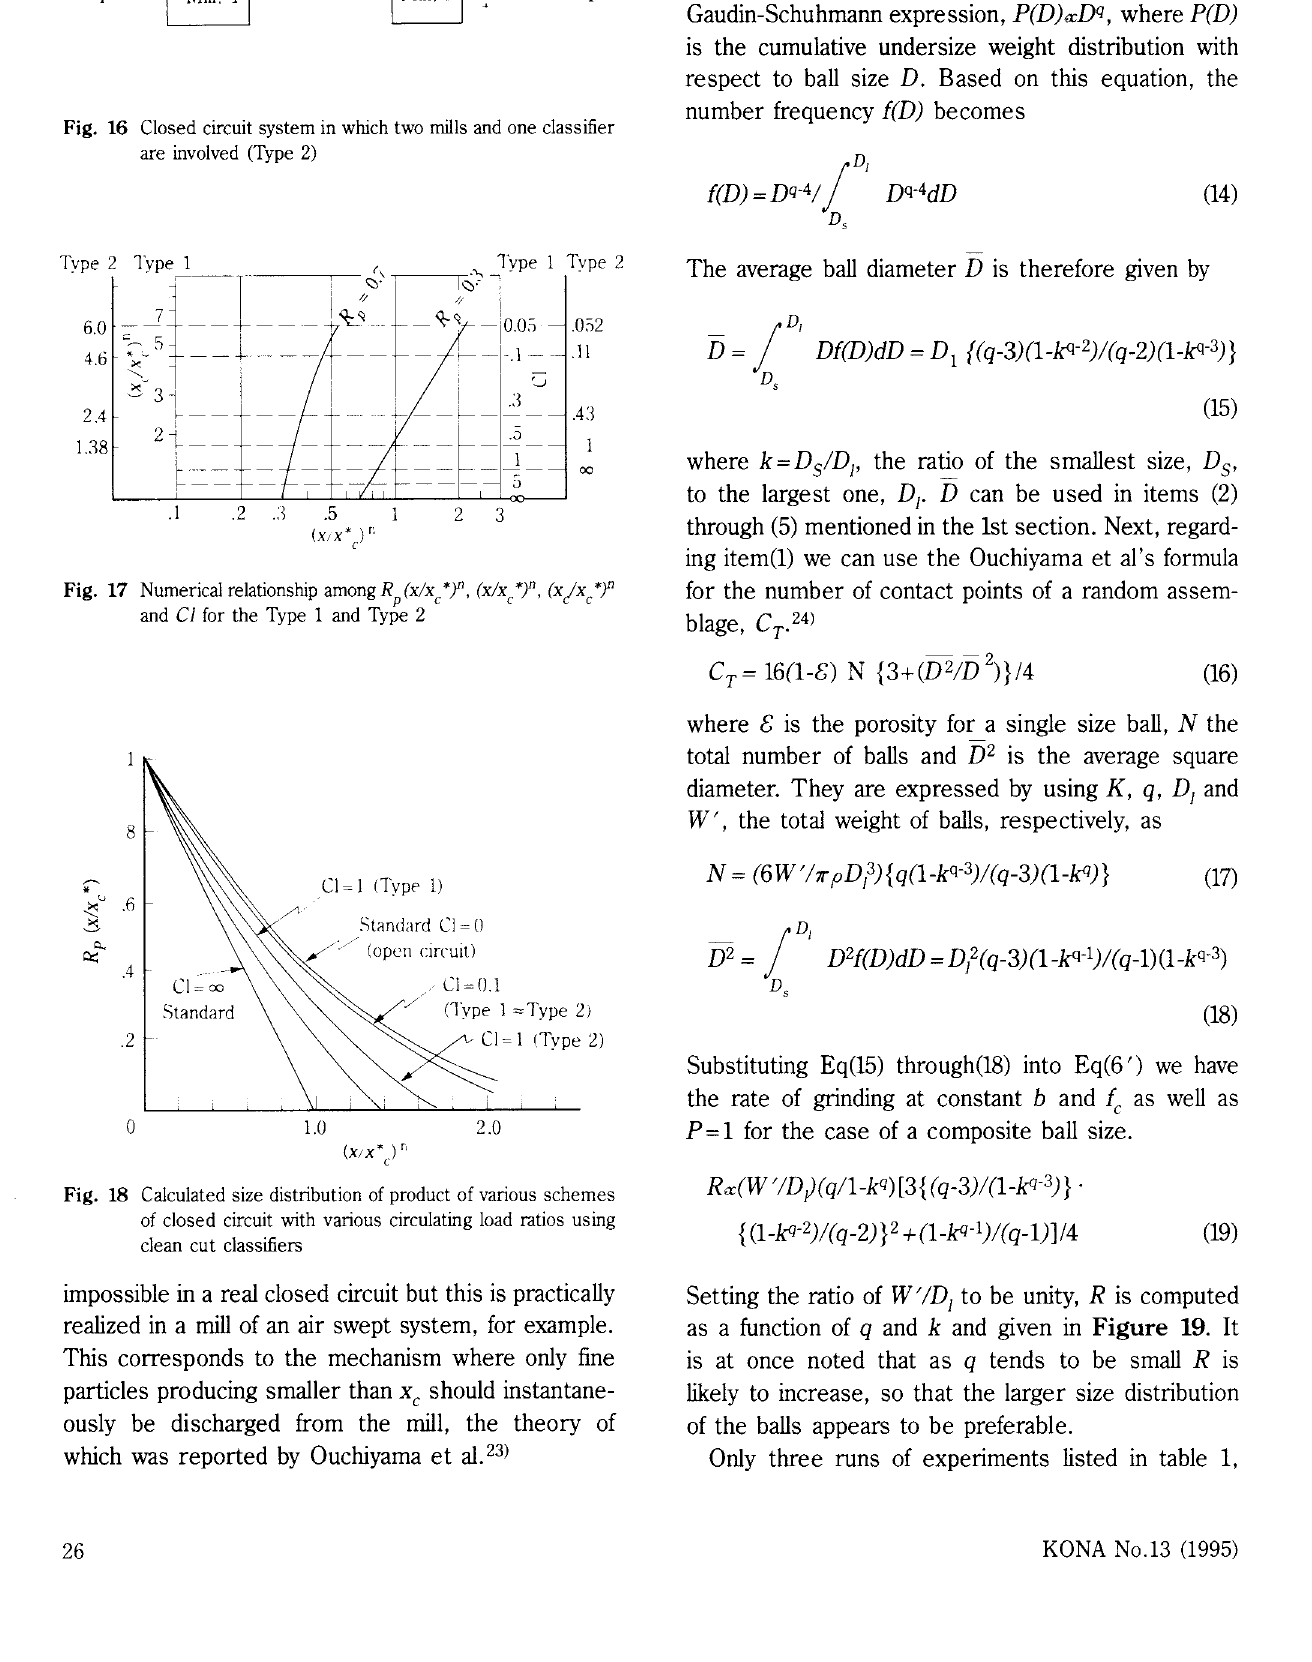
Fig. 16 Closed circuit system in which two mills and one classifier are involved (Type 2)